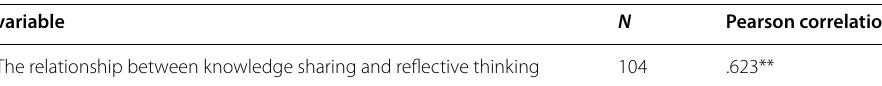
Table 6 Relationship between knowledge sharing and critical thinking variable N Pearson correlation The relationship between knowledge sharing and reflective **Correlation is significant at the 0.01 level (2‑tailed)